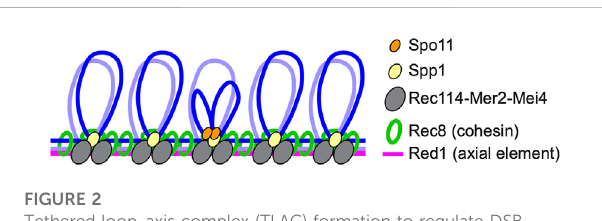
FIGURE 2 Tethered loop-axis complex (TLAC) formation to regulate DSB formation in budding yeast. Schematic representation of the budding yeast TLAC. Spo11 partner Rec114-Mer2-Mei4 complex localizes to chromosome axes where Rec8 cohesin and an axial element Red1 reside, and Spp1, a component of the Set1/COMPASS complex, tethers Spo11-bound DSB hotspots within loops to chromosome axes via the interaction with